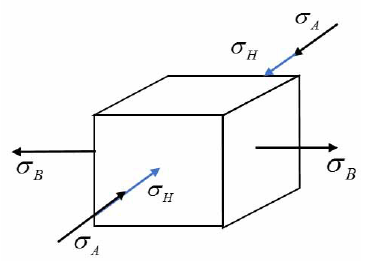
Figure 6. Stress state diagram of the element